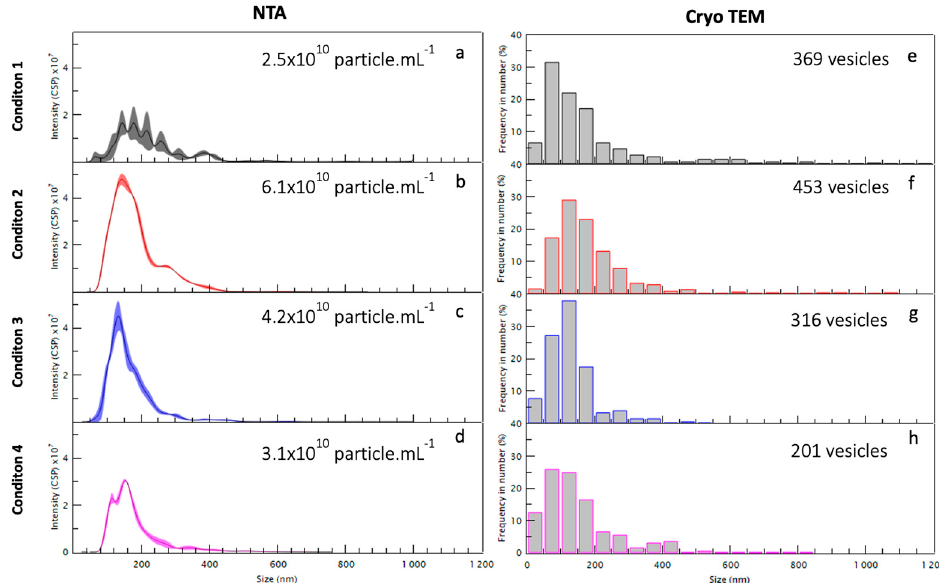
Figure 3. Size histograms of the EVs populations obtained from analysis of NTA ( a-d ) and Cryo-TEM ( e–h ) images using sequential centrifugation 1, 2, 3, and 4.